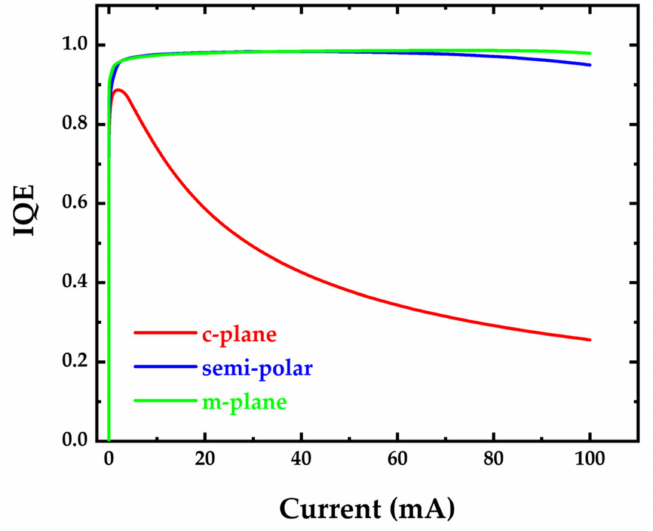
Figure 5. The simulated internal quantum efficiency of c-plane (0001), semipolar (2021), and m-plane (1010) micro-LEDs as a function of